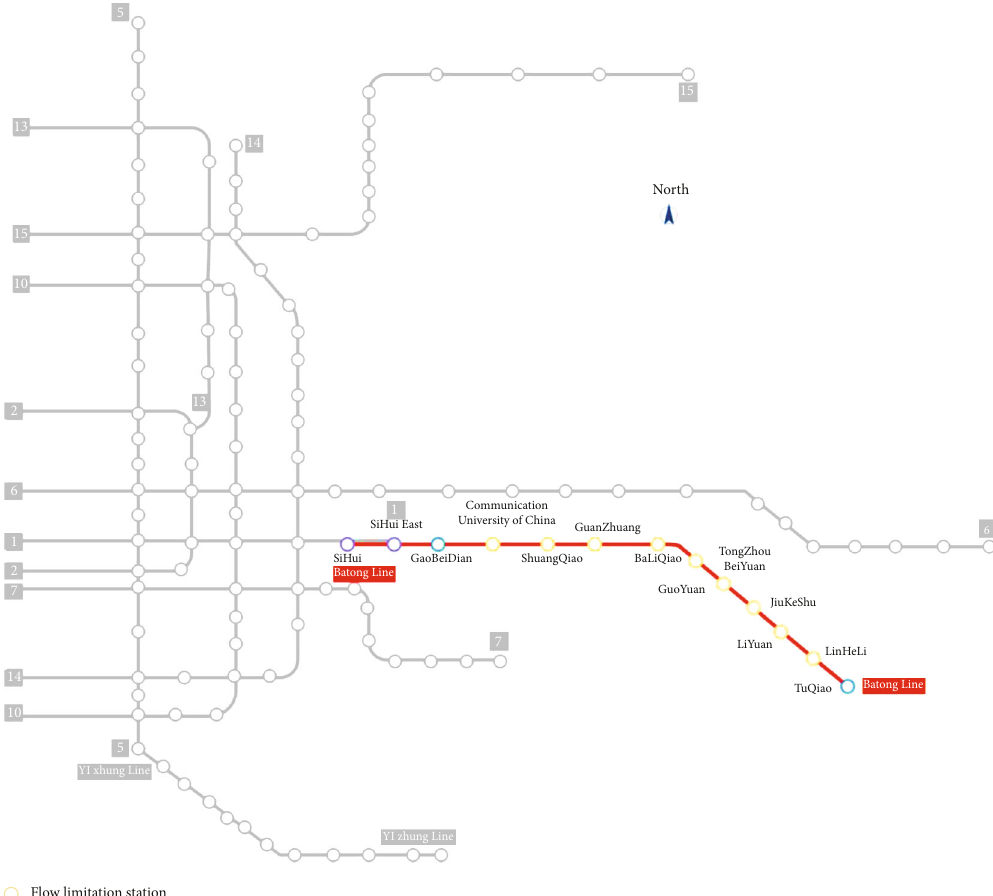
Figure 5: Illustration of Batong line in Beijing